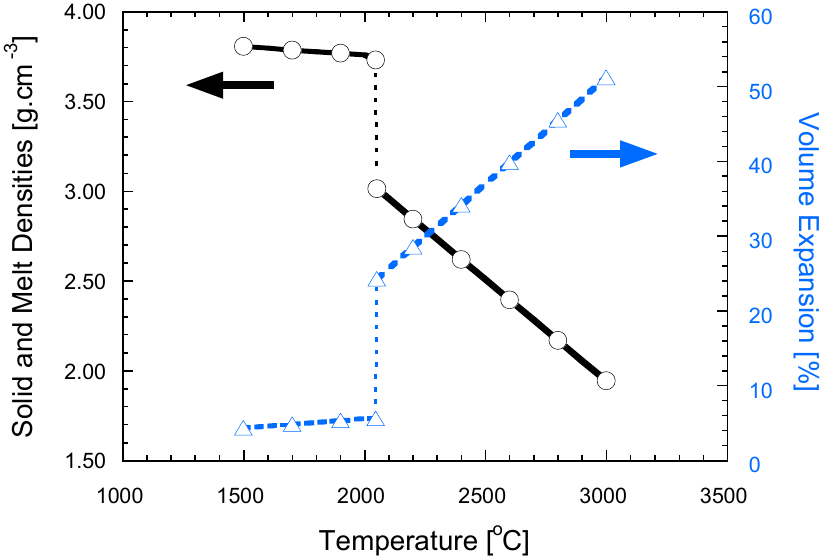
Figure 2. Densities of crystalline alumina and its melt (solid black line) versus temperature exhibits discontinuous decrease at the melting temperature. The corresponding increase in the specific volume expansion with temperature presented by the dashed blue line. Data for the melt density used from reference [36].